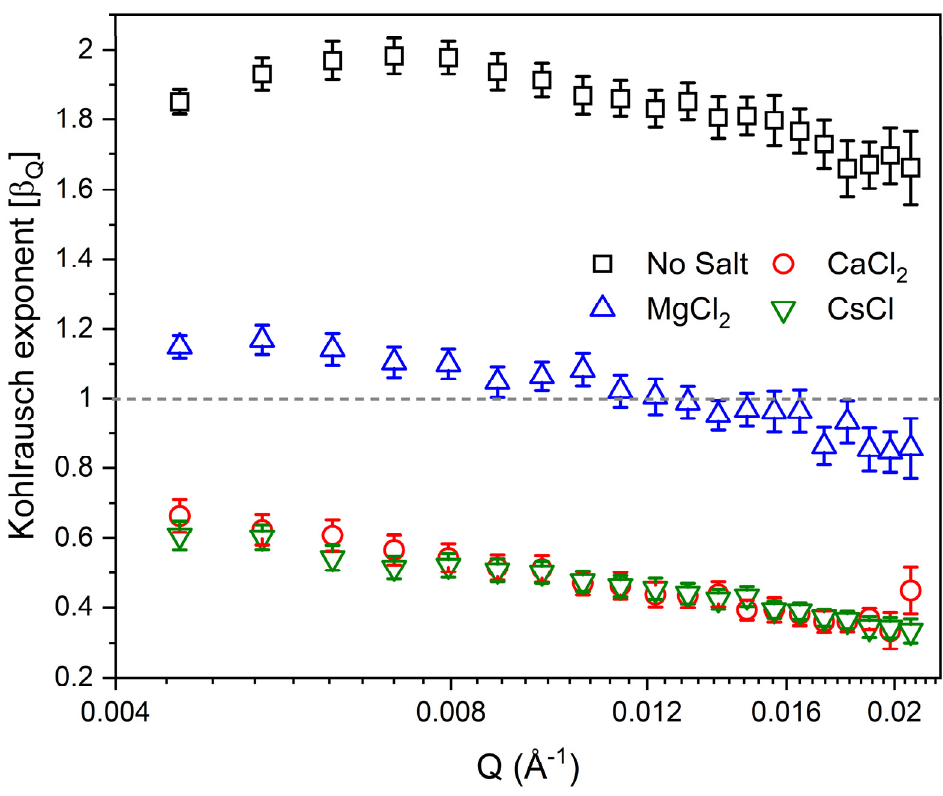
Figure 4. The Kohlrausch exponent of 3 wt% aqueous laponite suspension prepared in 5 mM of CaCl 2 , MgCl 2 and CsCl, and without salt as a function of the wave vector, Q